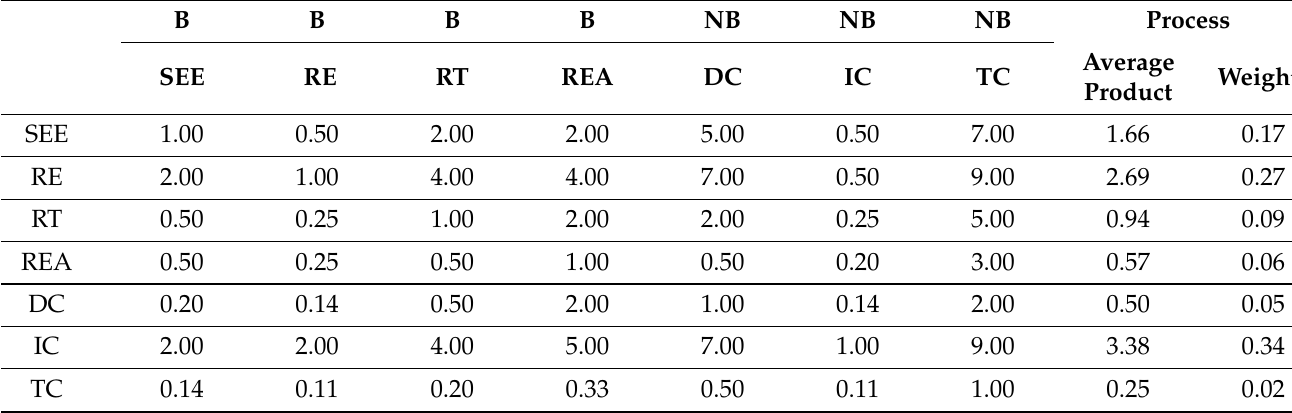
Table 18. The AHP analysis for calculating the weights of each criterion. B ≡ Beneficial, NB ≡ Non-Beneficial. SEE ≡ System Efficiency Enhancement, RE ≡ Reliability Enhancement, RT ≡ Reduced Theft, REA ≡ Renewable Energy Adoption, DC ≡ Deployment Challenges, IC ≡ Investment Cost, TC ≡ Technological Challenges.